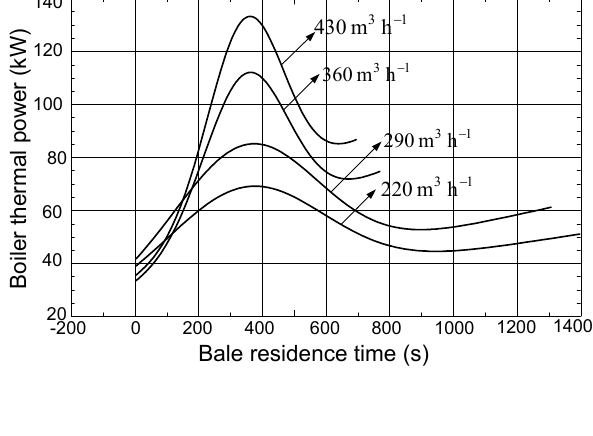
Figure 4. Correlation between boiler thermal power and bale residence time, model (1), recirculation